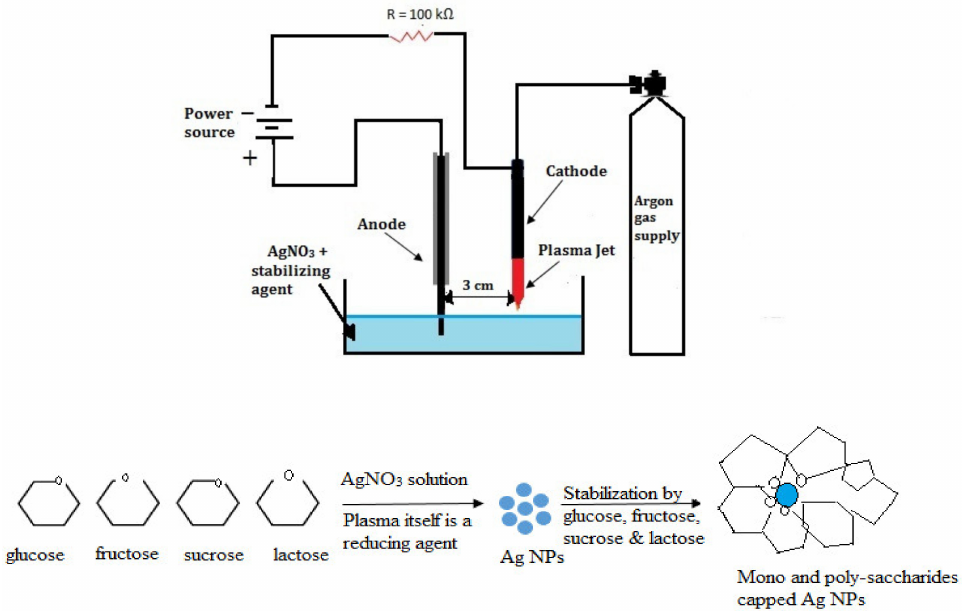
Figure 1. Illustration of experimental setup for liquid-plasma reduction, proposed mechanism and graphical representation for the formation of